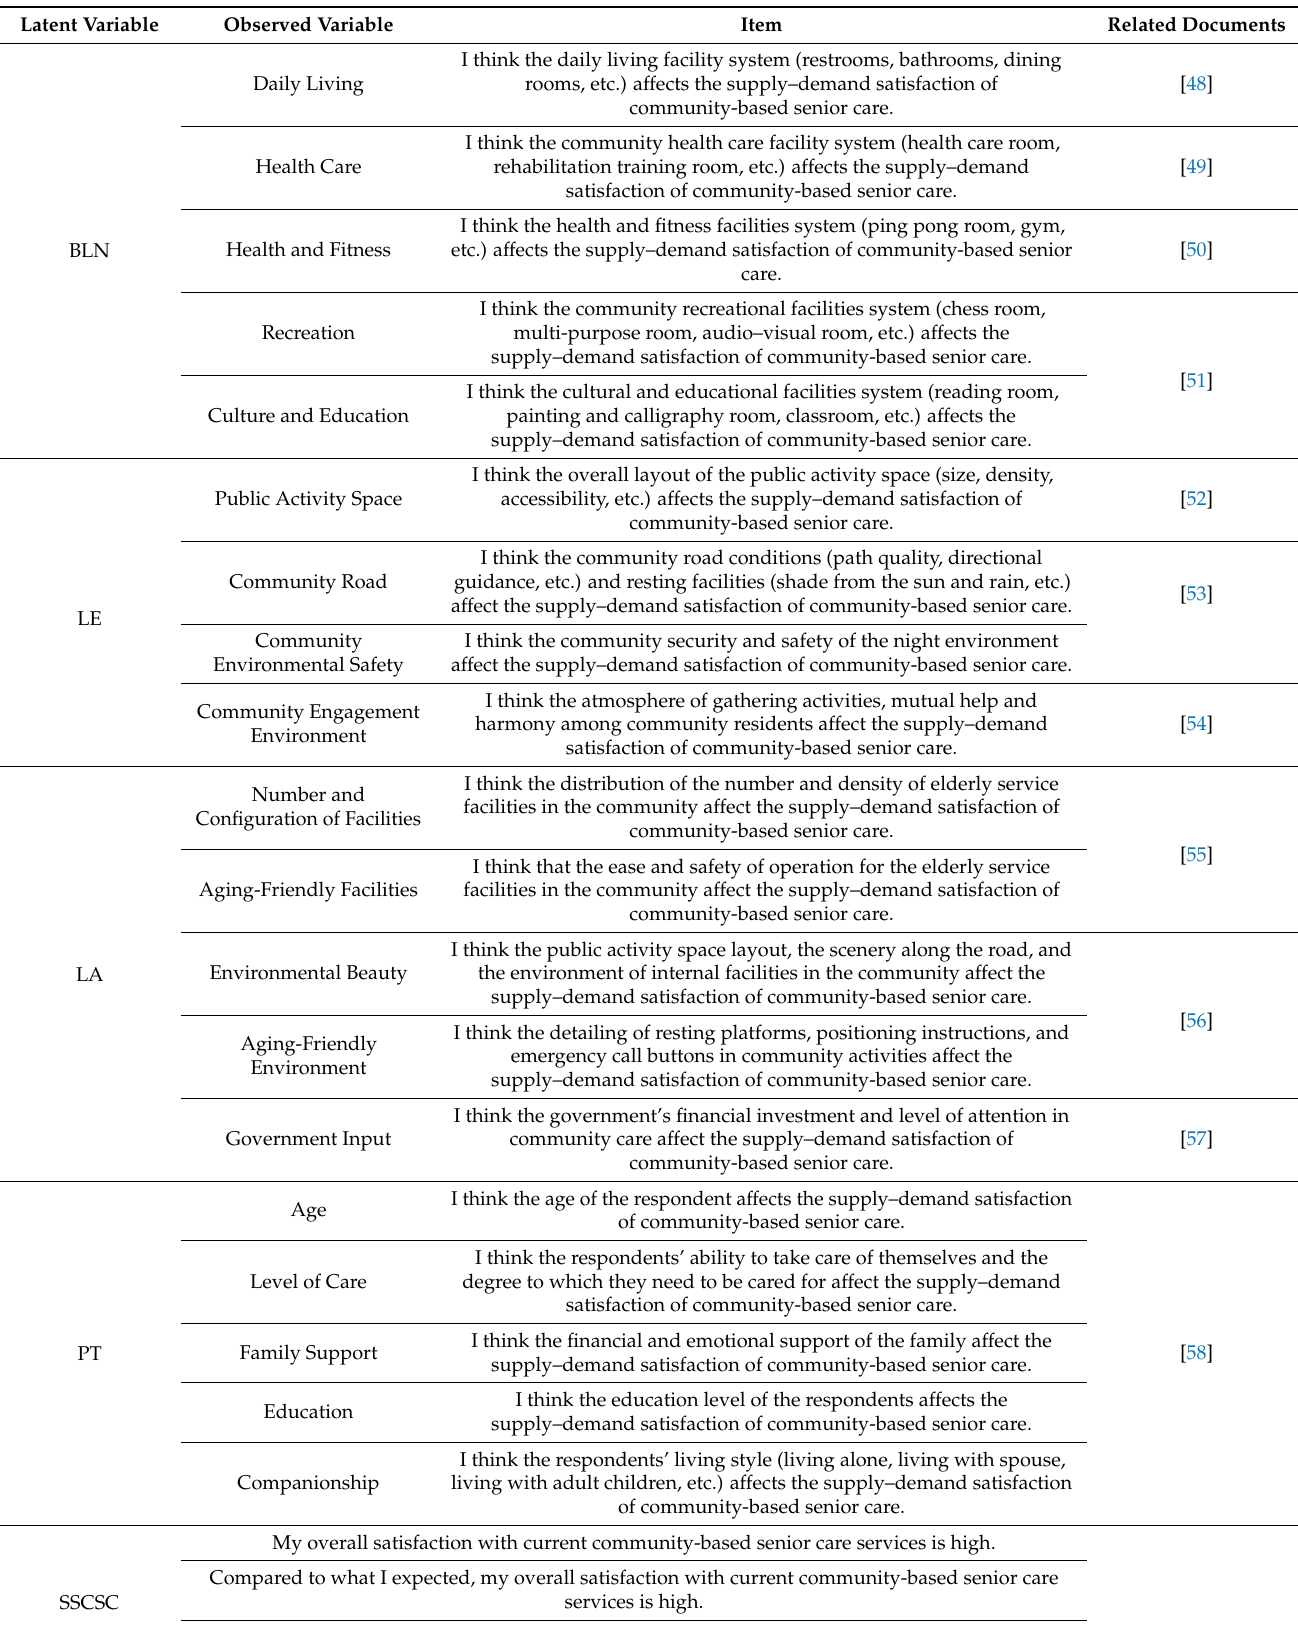
Table 1. Survey items related to the